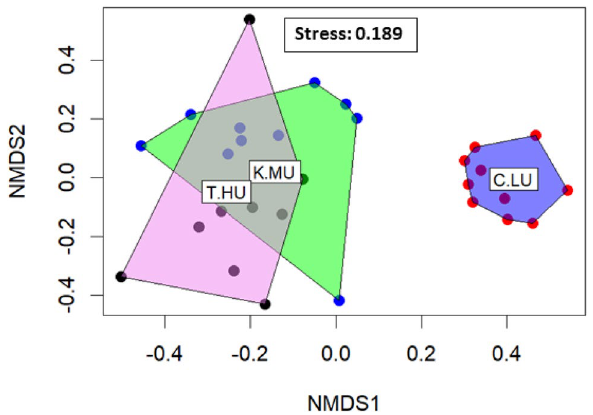
Figure 4. The NMDS plots illustrate the sacred groves of three urbanization levels on ant community (presence-absence data). Plots: T.HU = highly-urbanized Trivandrum; C.LU = less-urbanized Kodagu; and K.MU = moderately-urbanized